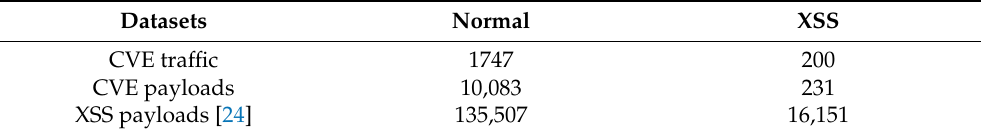
Table 6. Experimental dataset.